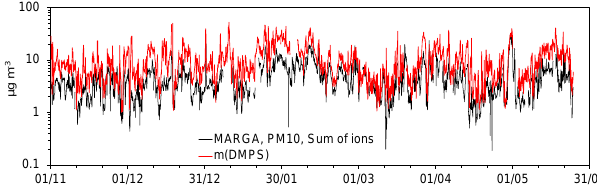
Fig. 2. Sum of inorganic ion concentrations in aerosols measured with MARGA in the size range D p < 10µm (noting that before 19 January 2010 there was only a total aerosol inlet in use) and the mass concentration of particles estimated from the particle number size distributions ( m (DMPS)) in the size range D p < 1µm and as- suming the density of 1.5gcm − 3